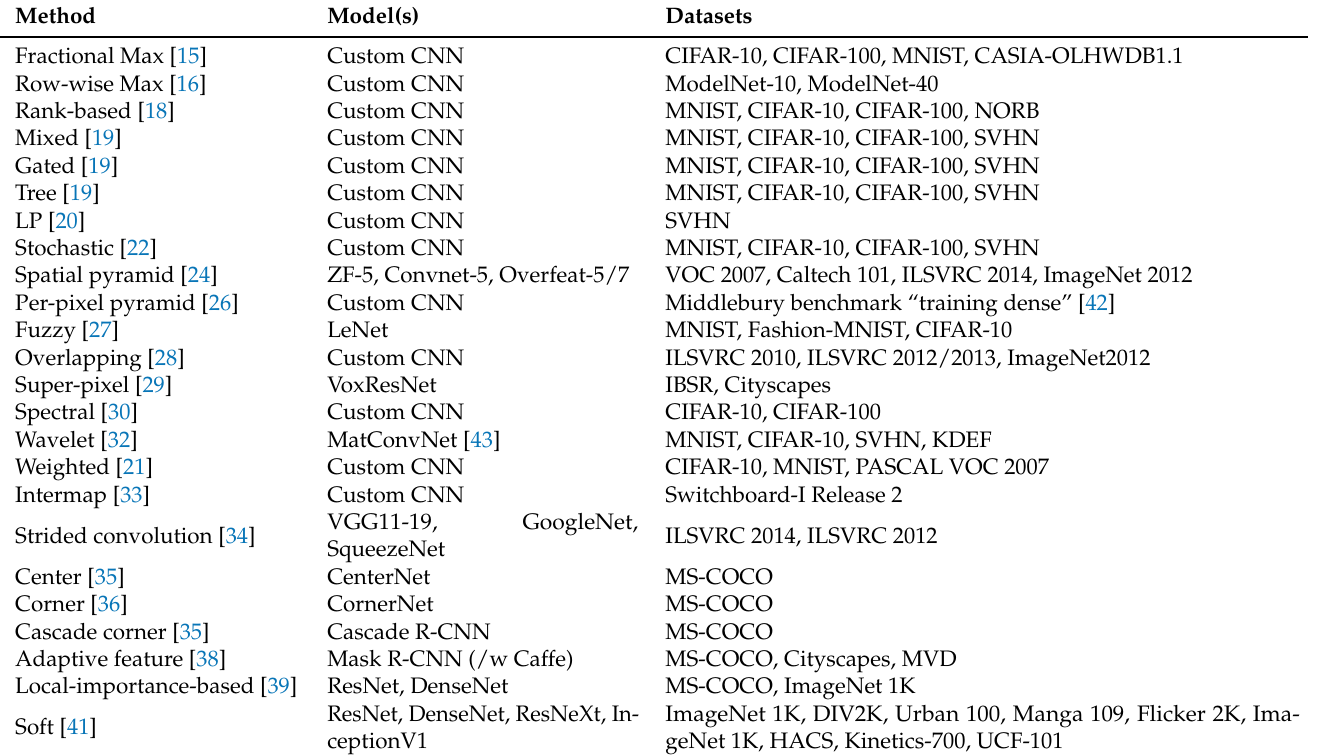
Table 3. A cumulative table of models and datasets used in each method’s publication.